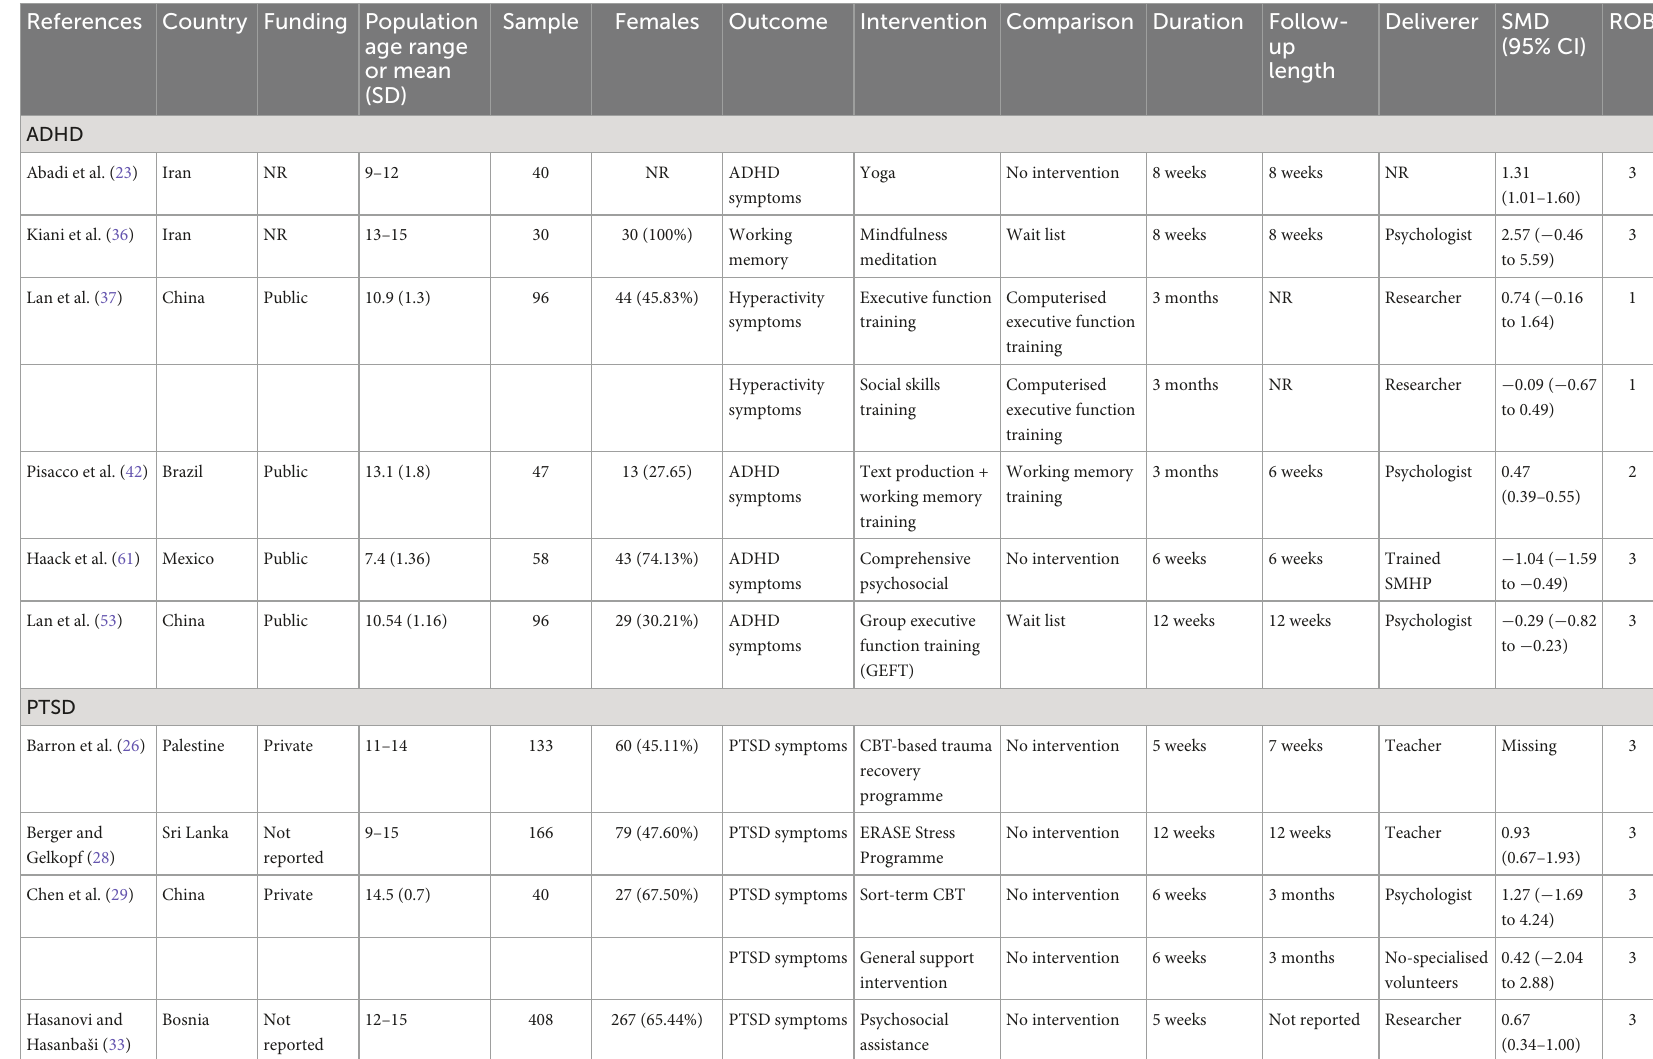
TABLE 1 Characteristics of individual included